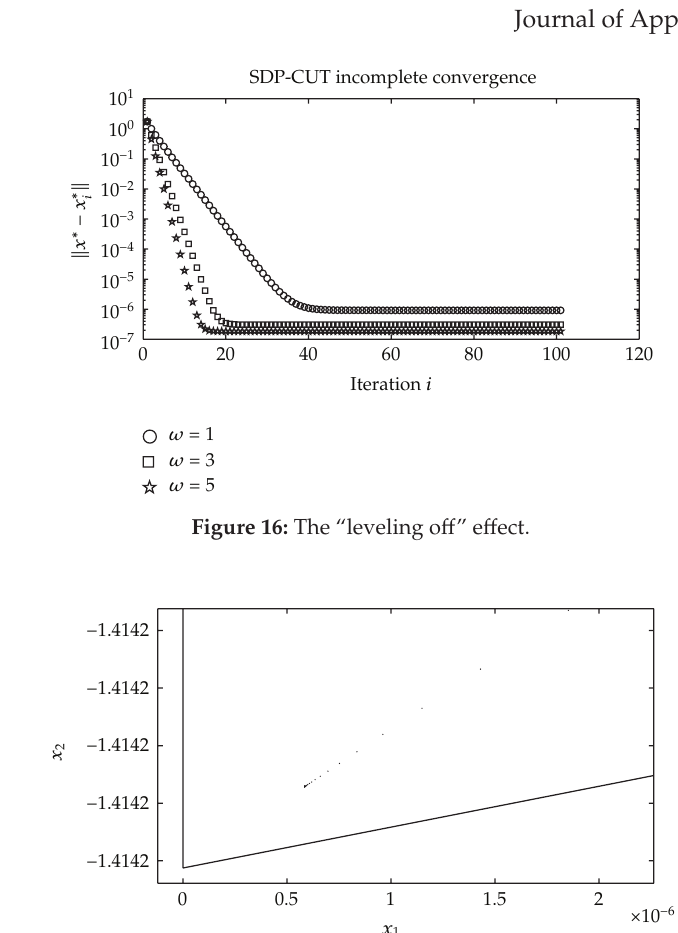
Figure 17: The “leveling o ff ” e ff ect zoomed in on feasible